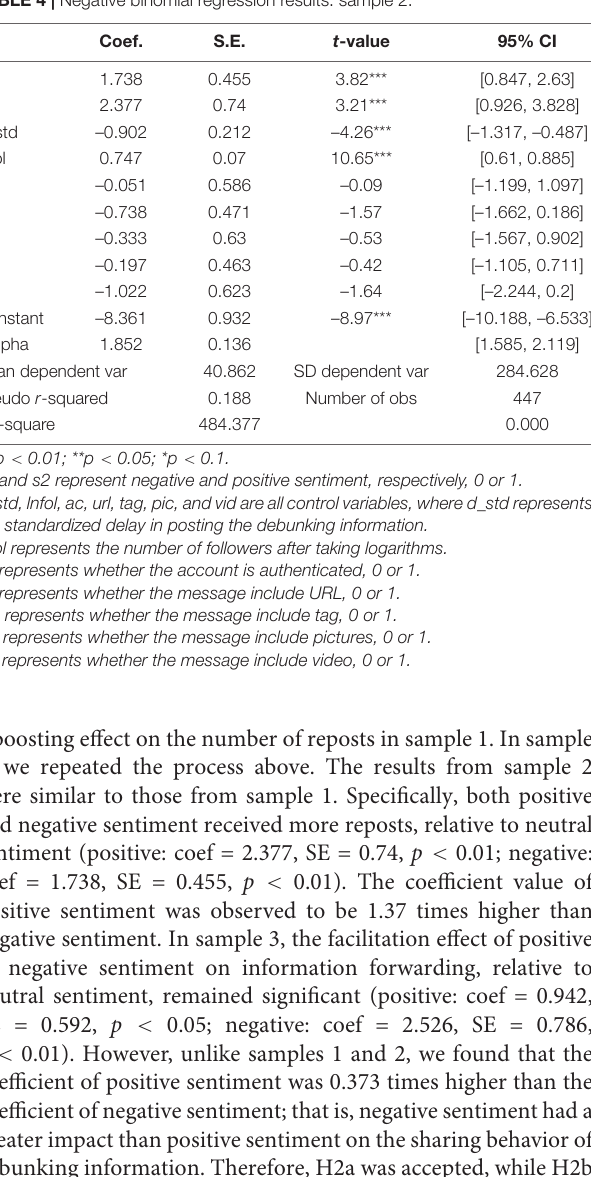
TABLE 4 | Negative binomial regression results: sample